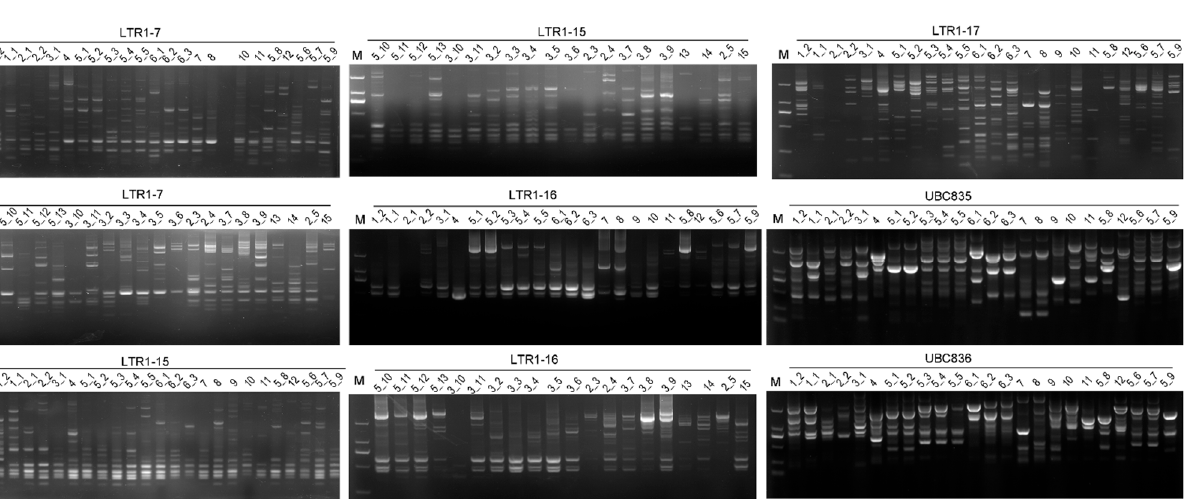
Figure 1. Electrophoresis pro fi les of the rhododendron accessions from BDNR as revealed by inter- retrotransposon ampli fi ed polymorphism (IRAP) and inter-simple sequence repeat (ISSR). The lanes corresponding to the accessions (Table S1) are marked on the top of the gel map. The characters on the horizontal line are the IDs of IRAP or ISSR markers. Lanes that did not exhibit bands were retested and the binary data obtained were incorporated into subsequent analyses. M, D2000 DNA marker (Tiangen Biological Company, Beijing, China).